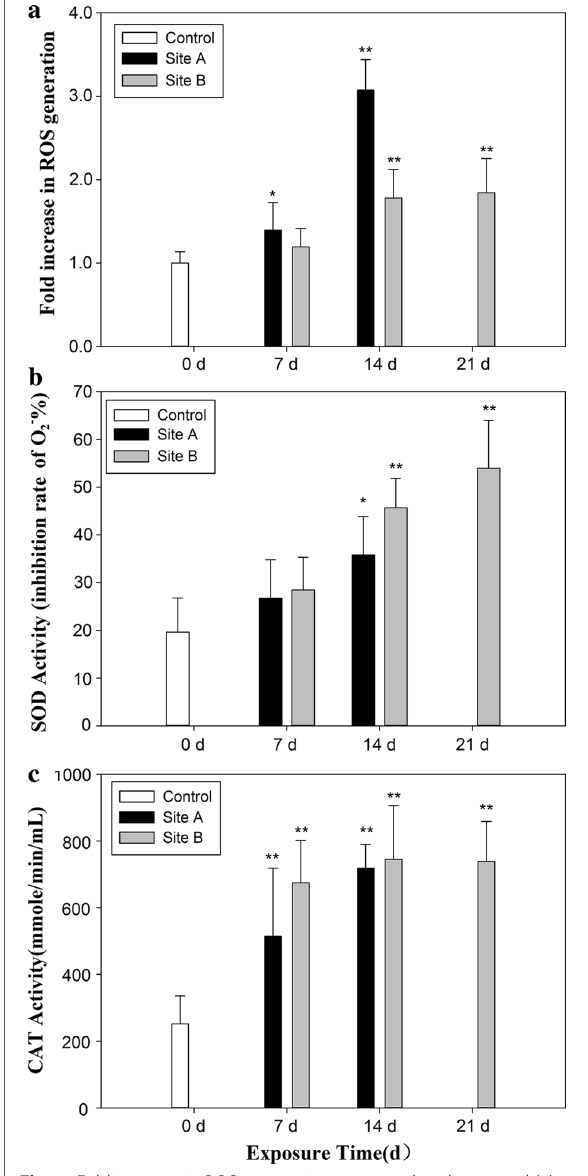
Fig. 4 Fold increase in ROS generation compared to the control ( a ) and activities of antioxidant enzymes (SOD and CAT activities) ( b , c ) in the hepatopancreas of snails ( Bellamya aeruginosa ) caged at sites A and B over the duration of the exposure experiments in Taihu Lake. Results are mean SD. Data are given from 30 individuals in each ± sample. Asterisks indicate significant difference from the control ( P < 0.05); double asterisks indicate significant difference from the control ( P < 0.01)